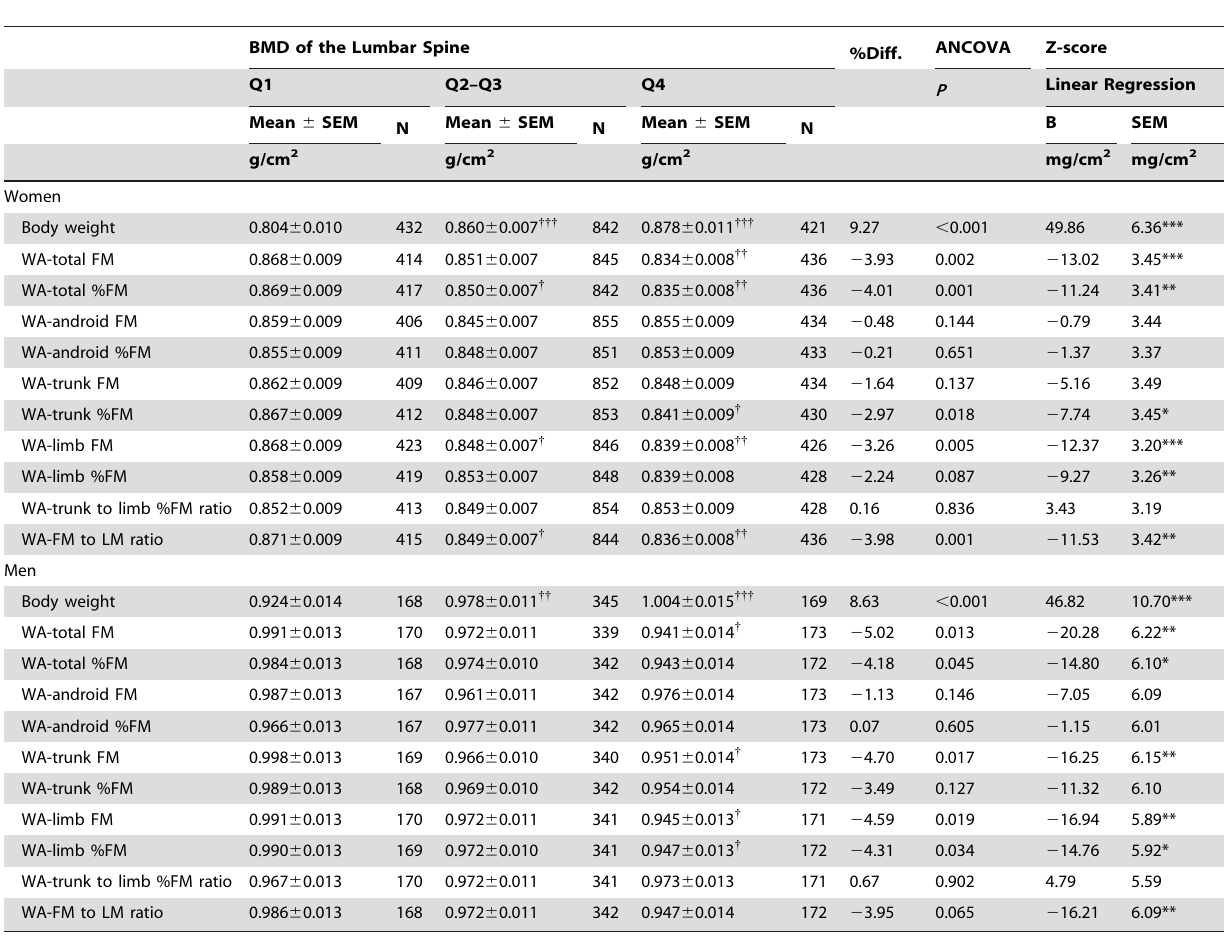
Table 2. Covariate-adjusted mean (SEM) bone mineral density of the lumbar spine by quartiles of each WA-index of FM.